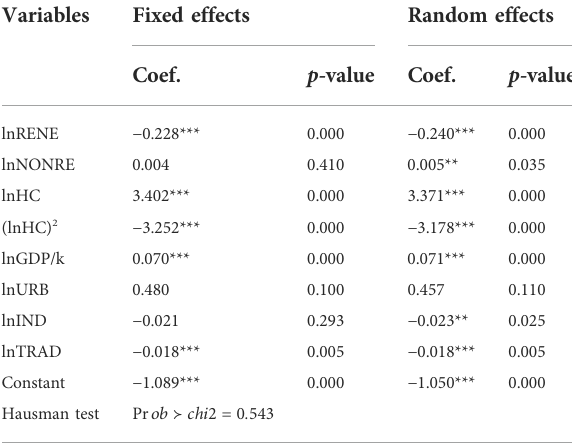
TABLE 14 Results of the nonlinear model using the FE and RE estimators.